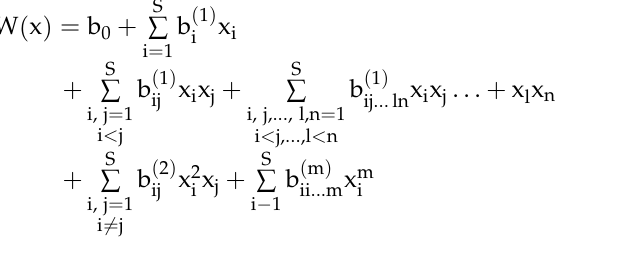
Figure 16. Standard deviation of the test results for a welding speed of x 2 = 200 mm/min.